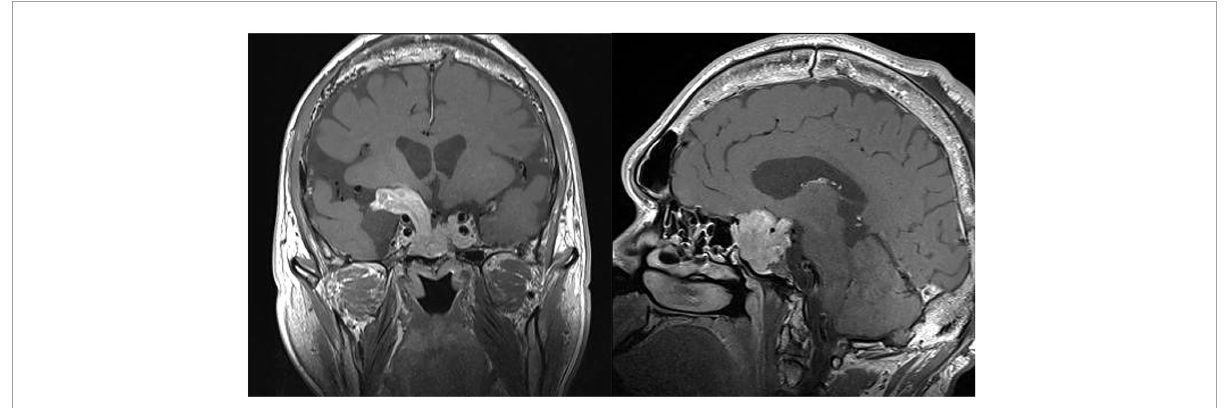
FIGURE3 The magnetic resonance imaging (MRI) of coronal (left) and sagittal (right) sections showing a pituitary macroadenoma. Specifically, the maximum cross-sectional area was 42 mm × 37 mm, which had compressed the optical chiasm, invaded the skull base bone, and surrounded blood vessels in sellar